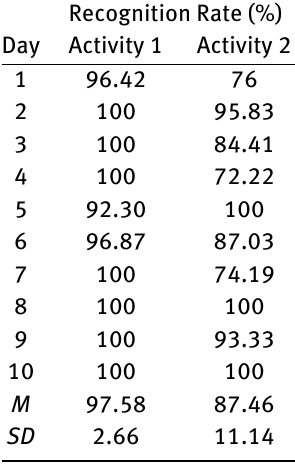
Table 1: Self validation for all days (CASAS dataset).